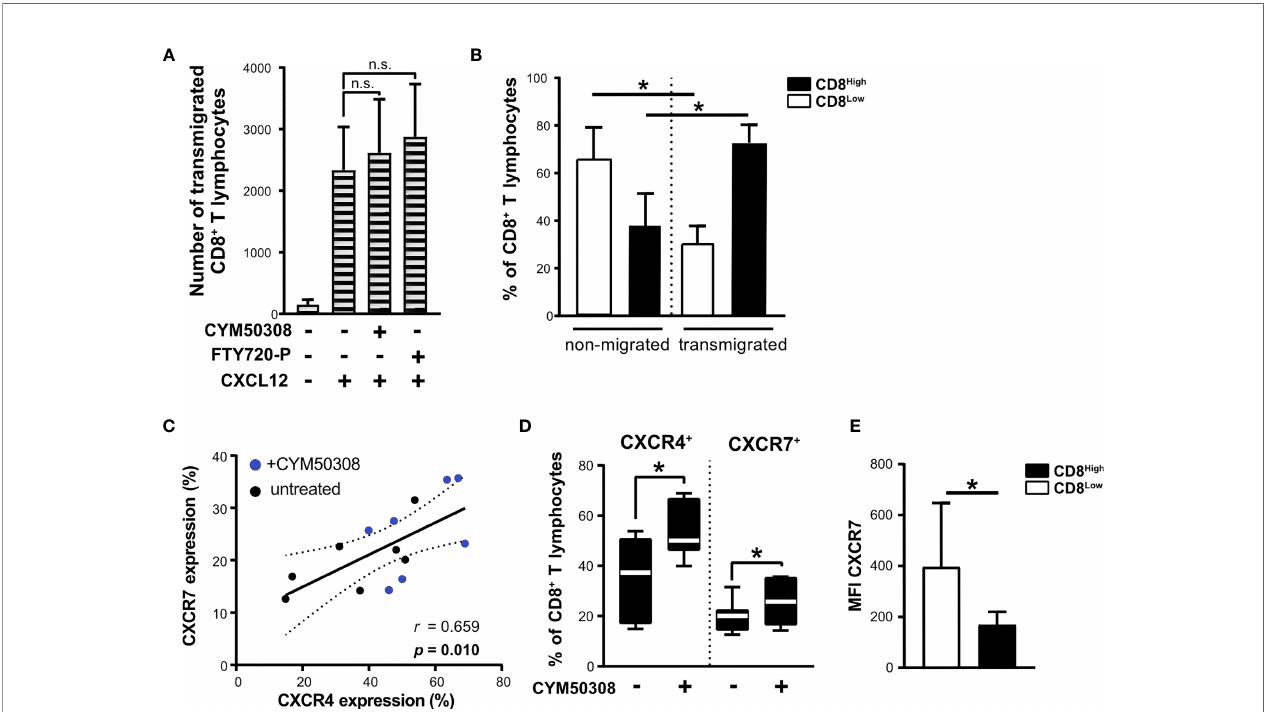
FIGURE 7 | Unchanged migration towards CXCL12 after S1P 4 stimulation due to lower migratory potential of CD8 Low T lymphocytes and co-induction of CXCR7. (A) Migration assay for 2 h with 20 nM CXCL12 (SDF1 a ) within the lower compartment. Absolute count of all transmigrated CD8 + T lymphocytes (shaded bars) was quanti fi ed using MACSQuant 10. CD8 + T lymphocytes were cultivated after puri fi cation for 40 h under serum withdrawal within the inserts of Transwell plates. Daily stimulation with either selective S1P 4 receptor agonist (CYM50308, 200 nM) or S1P receptor modulator FTY720-P (200 nM). Differences in absolute numbers of transmigrated CD8 + T lymphocytes between untreated and stimulated samples were not signi fi cant (n.s.) using Wilcoxon matched pairs signed rank test. (B) Analysis of CD8 Low and CD8 High T lymphocytes within the upper compartment (non-migrated) and lower compartment (transmigrated cells) after 2 h of migration towards CXCL12. Flow cytometry data are obtained from n = 6 donors of three independently performed experiments. (C) Positive correlation of CXCR4 (APC) and CXCR7 (PE) protein expression on all CD8 + T lymphocytes analyzed by fl ow cytometry. (D) CXCR4 and CXCR7 expression after S1P 4 receptor agonist stimulation (black-white box plots). The box plot marks the 5 th percentile, the median and 95 th percentile. (A – E) Data are obtained from n = 7 donors of three independently performed experiments. Spearman´s correlation ( n = 14, r = 0.659, *p = 0.01). Dashed lines indicate 95% con fi dence intervals bands for the regression line. (E) Comparison of CXCR7 mean fl uorescence intensity (MFI) on CD8 Low and CD8 High , *p ≤ 0.05, using Wilcoxon matched pairs signed rank